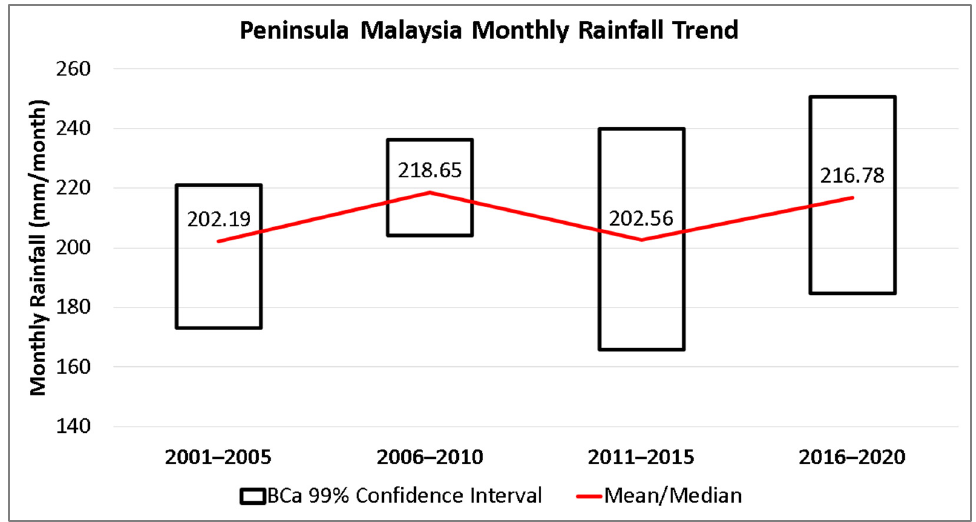
Figure 10. Monthly rainfall trend in Peninsula Malaysia from 2001 to 2020 (divided into 5-year interval).